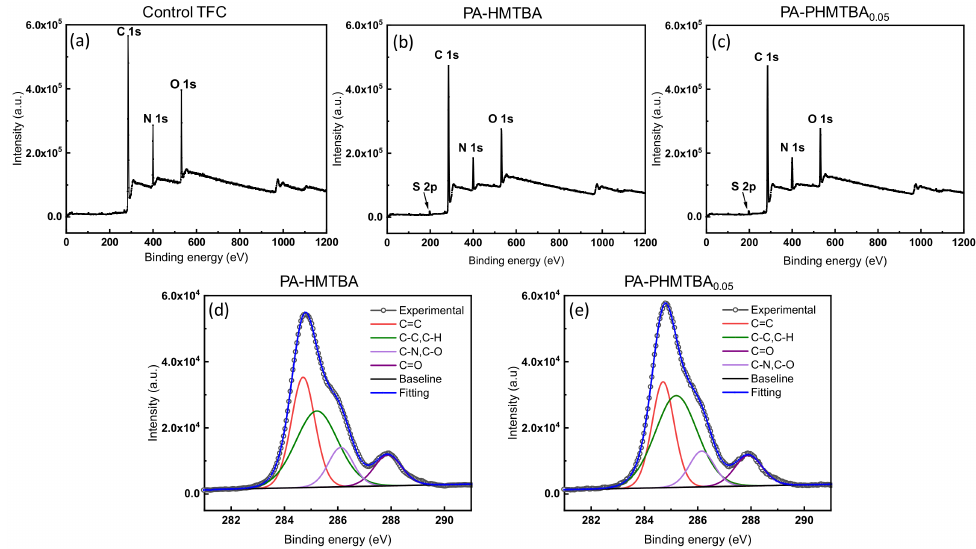
Figure 4. XPS assessment of as-fabricated membranes. XPS spectra of ( a ) control TFC membranes, ( b ) PA-HMTBA membranes, and ( c ) PA-PHMTBA membranes; C1s survey spectra of ( d ) PA-HMTBA and ( e ) PA-PHMTBA